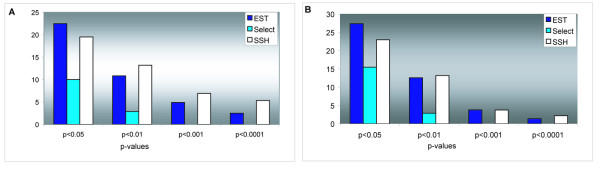
Performance of the clone sets used for preparation of the microarray. Figure shows frequencies of genes that were differentially expressed in at least 5 samples at different p-values (Student's t-test). A: this study (stress response), B: related experiments (exposure to aquatic contaminants [34], response to stress, cortisol and combination of these treatments, challenge with bacterial antigens, M74 disease). SSH – subtracted cDNA libraries, EST – normalized libraries, Select – genes chosen by the Gene Ontology functional categories.